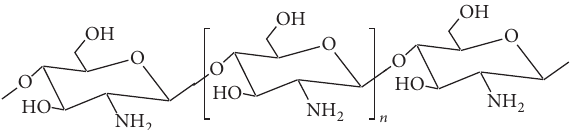
Figure 1: Structure of a chitosan